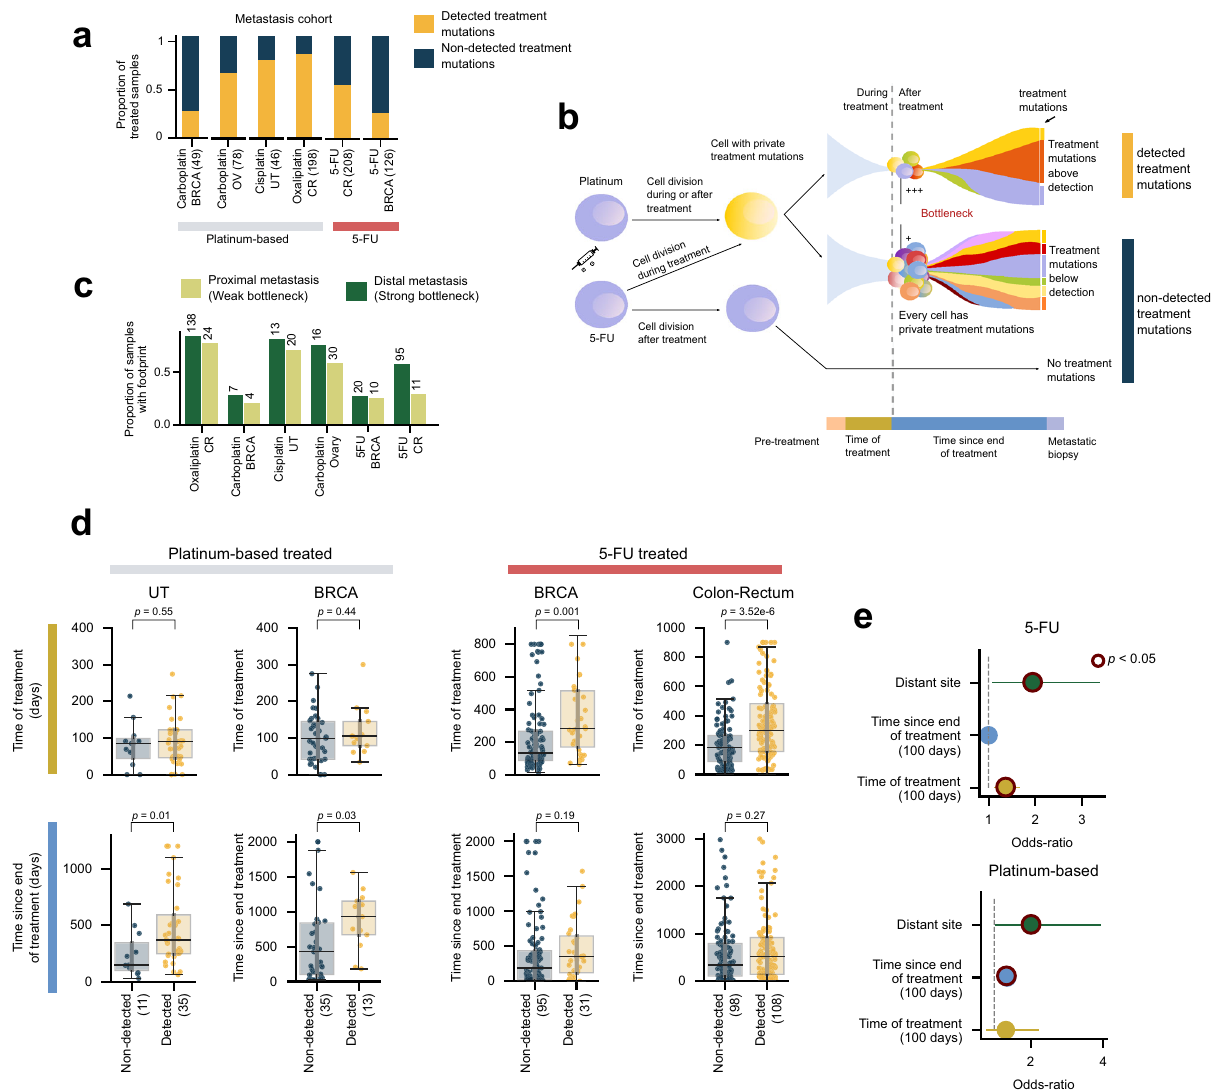
Fig. 2 Different mutagenic mechanisms of platinum-based drugs and 5FU. a Proportion of samples from metastatic tumors with different organs of origin taken from donors exposed to platinum-based drugs or 5FU with detectable treatment mutations. b Proportion of samples with detectable treatment mutations among distant or proximal metastases. c Platinum-based drugs and 5FU contribute mutations in the DNA via two different mechanisms (illustrated by the blue cells in the left panel). While the former creates adducts on the DNA, the latter alters the pool of nucleotides available for DNA replication. Thus, cells exposed to platinum-based drugs will carry mutations of the treatment after DNA replication, irrespective of whether cells are quiescent at the time of exposure or not (top arrow). On the other hand, 5FU-exposed cells will only incorporate mutations if their DNA is replicated while the pool of nucleotides is still distorted by the drug (middle arrow). If it has been restored before DNA replication, no mutations will be incorporated (bottom arrow). Therefore, immediately following exposure, two scenarios are possible: the surviving cells either bear treatment mutations (yellow cell) or not (blue cell). We reasoned that whether the treatment mutations are visible at the time of metastasis depends on the strength of the evolutionary bottleneck facing the primary tumor and its timing with respect to the exposure (see periods of time represented in different colors below fi gure). A stronger bottleneck during or immediately after treatment will lead to treatment mutations detectable through bulk sequencing (top drawing). On the contrary, a weaker bottleneck, or a bottleneck suffered before treatment (for example, if the metastasis predates the treatment) will lead to treatment mutations below the limit of detection of the bulk sequencing (middle drawing). d Distribution of time of treatment (days) and time after treatment (days) of samples of metastatic tumors of different organs of origin with detectable or undetectable treatment mutations taken from patients exposed to platinum-based drugs or 5FU. Groups of metastatic tumors were compared using a one-tailed Mann – Whitney test. The box in each boxplot delimits the fi rst and third quartiles of the distribution (with a line representing the median); the whiskers delimit the lowest data point above the fi rst quartile minus 1.5 times the interquartile distance and the highest data point below the third quartile plus 1.5 times the interquartile distance. e Results of logistic regressions showing the in fl uence of different variables on the detection of platinum-based drugs (bottom) or 5FU (top) related mutations across metastatic tumors. Variables that signi fi cantly in fl uenced the likelihood of detection are circled. BRCA breast adenocarcinoma, OV ovarian adenocarcinoma, UT urinary tract tumors, CR colorectal adenocarcinoma, 5-FU 5- fl